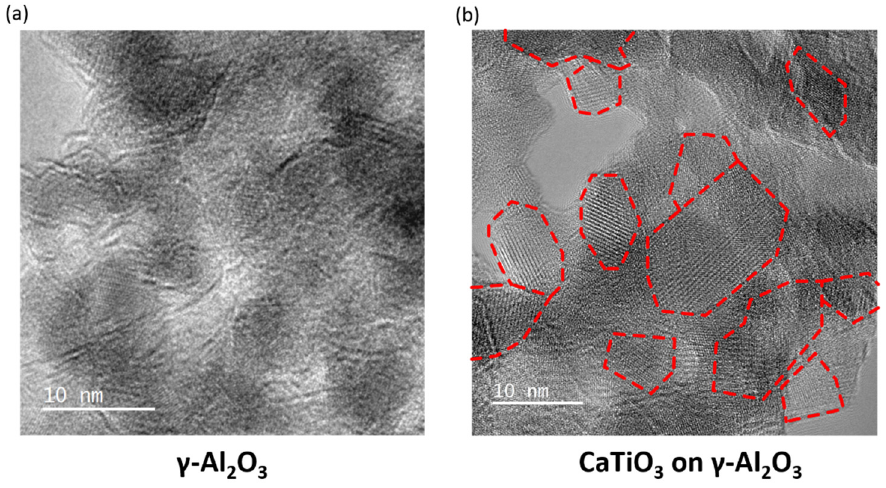
Figure 5. HR-TEM image of ( a ) bare Al 2 O 3 ; ( b ) 18 wt% CaTiO 3 /Al 2 O 3 .